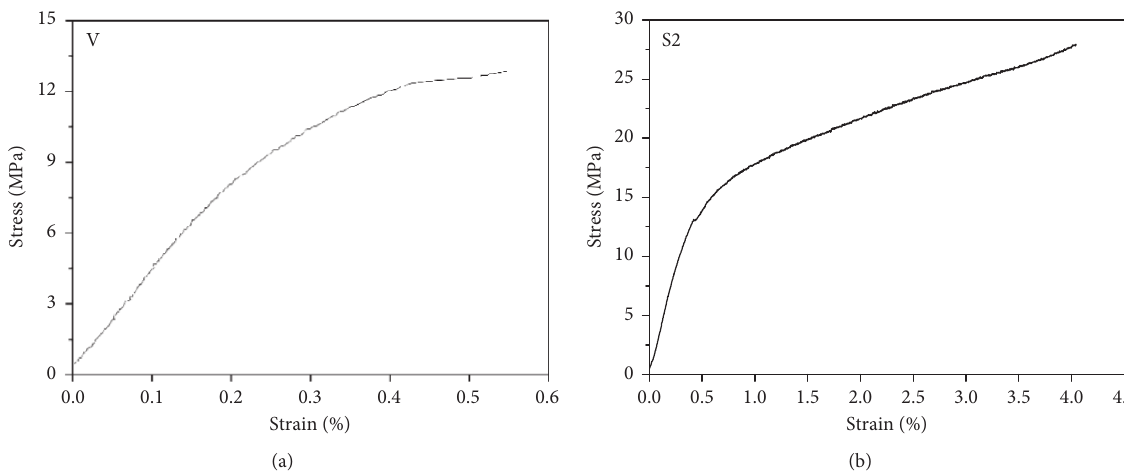
Figure 4: Triaxial stress-strain curve. (a) Without adding SiC whisker. (b) 1% SiC whisker added.